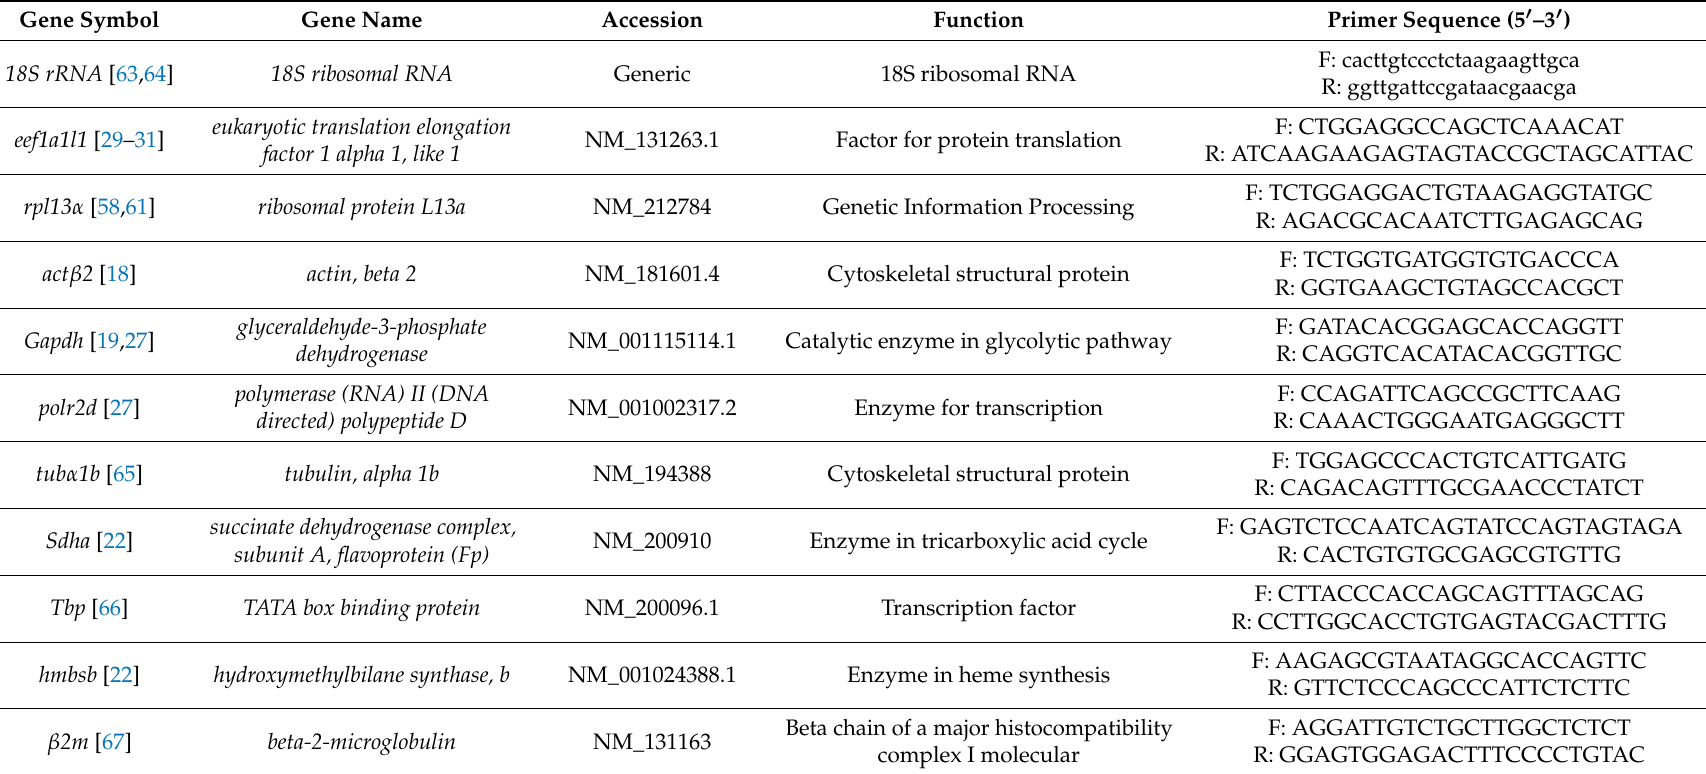
Table 4. Candidate reference genes of zebrafish embryos used in the toxicity